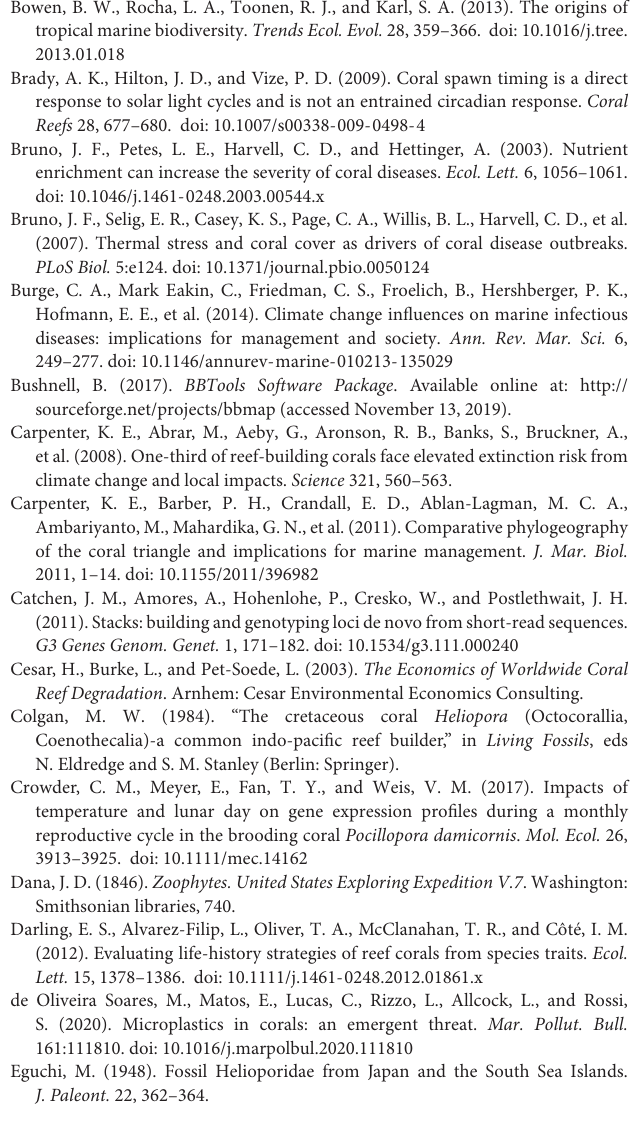
Supplementary Figure 1 | A bar plot of Heliopora sp. estimated by STRUCTURE ver. 2.3.4 assuming the number of cluster K = 3 using 225 SNPs obtained from the Stacks ( r = 0.9 with the option –write_single_snp ). Ten independent runs based on 200,000 burn-in followed by 200,000 Markov chain Monte Carlo (MCMC) replications were conducted using admixture models assuming correlated allele frequencies among 84 samples with uniform prior. The x-axis indicates each individual for Heliopora sp. that were classified into three subclades (sp.1–sp.3) in the phylogenetic tree ( Figure 1 ). Different colors of the y-axis indicate the probability of assignment to different clusters. Red allows indicate possible hybrid individuals. Supplementary Table 1 | Summary of sample information in this study: name of sampling country “Country,” name of sampling region “Region,” name of sampling site “Location,” longitude and latitude “Coordinates,” number of collected samples “Ns” and analyzed samples “Na,” ratio of assigned possible clones within each population “Rc,” name of Heliopora species group “Spp. group” and subclade “Subclade,” observed growth forms within each subclade “Major form (minor form),” and sampling years with published references “Year